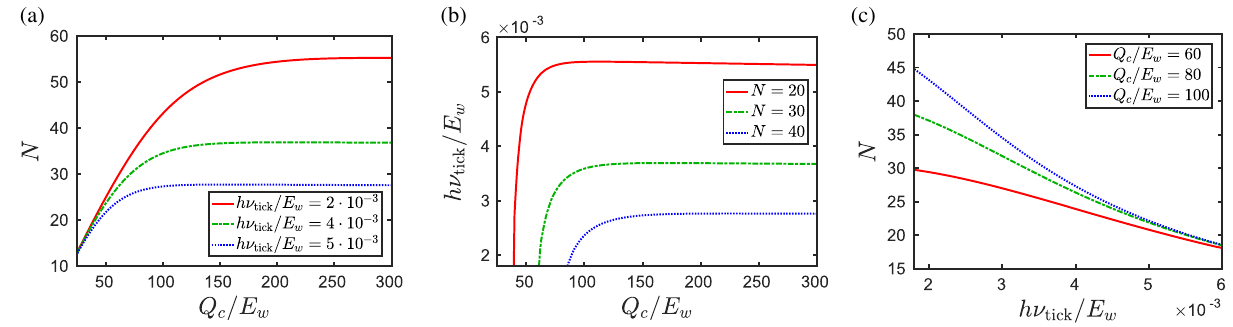
FIG. 2. Illustration of the fundamental trade-off between the dissipated heat and the achievable accuracy and resolution. (a) Accuracy N as a function of dissipated heat per tick Q , for various values of the resolution ν . At low energy, the accuracy increases linearly c tick with the dissipated energy, independently of the resolution. However, for higher energies, the accuracy saturates. (b) Resolution ν as a tick function of dissipated heat per tick Q , for various values of the accuracy N . The resolution first increases with dissipated energy but then c quickly saturates to a maximal value. (c) Trade-off between accuracy and resolution when the energy dissipation rate is fixed. The data 1000 E T E T are computed for fixed values of k , k and g ¼ ℏ γ ¼ ℏ Γ ¼ 0 . 05 E , while the ladder dimension d and cold qubit B c ¼ w B h ¼ w w ≪ E − 1 Þ E T E energy E are varied independently. Note that d ≥ 10 for all of the plotted points; thus, k , and we can γ ¼ ð d c B c ¼ w w safely ignore the absorption of a photon (i.e., the reverse of the decay